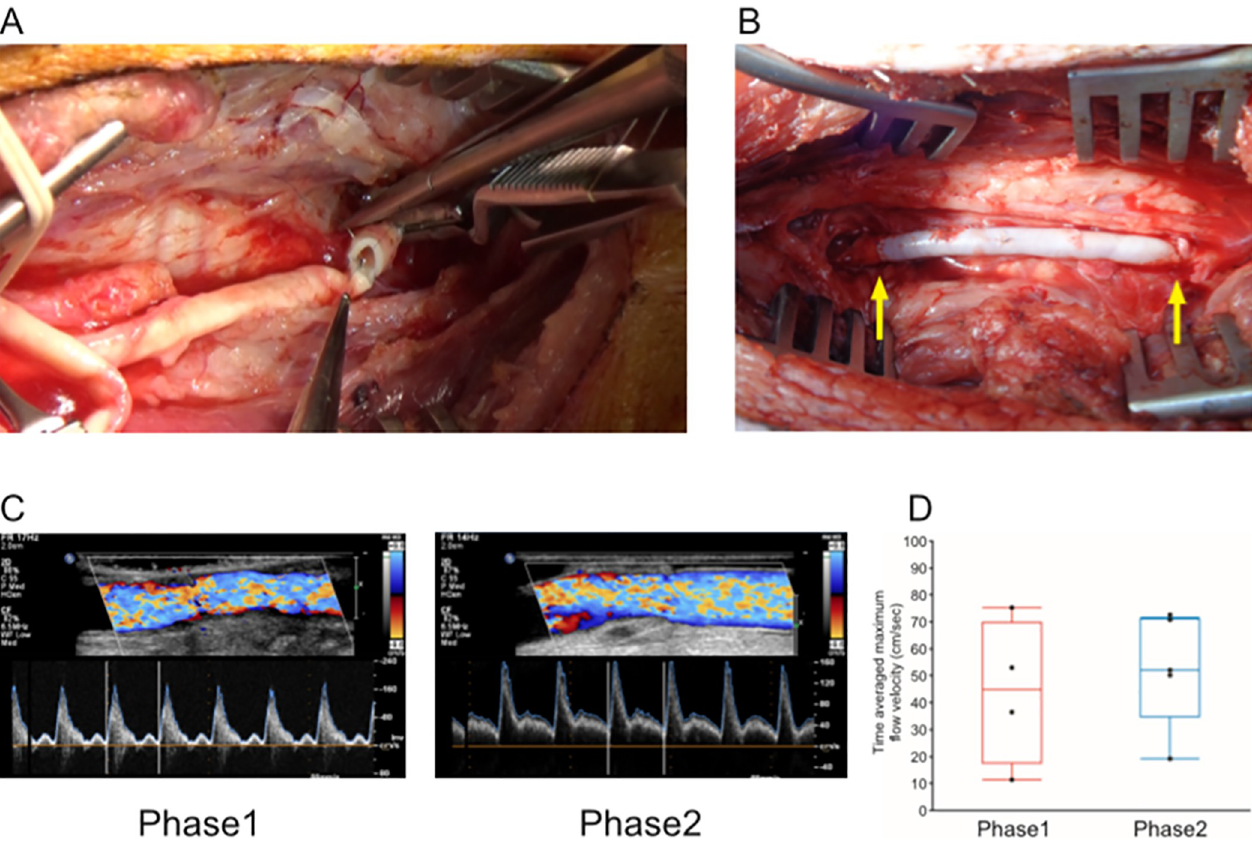
Fig 2. Implantation of decellularized graft into porcine carotid artery. ( A ) ( B ) A representative surgical view during (A) and after (B) anastomosis in moist condition (Phase 2). Yellow arrows indicate anastomosis sites. ( C ) Representative images of color Doppler ultrasound at the center of implanted graft (left; Phase 1, right; Phase 2). ( D ) Time averaged maximum flow